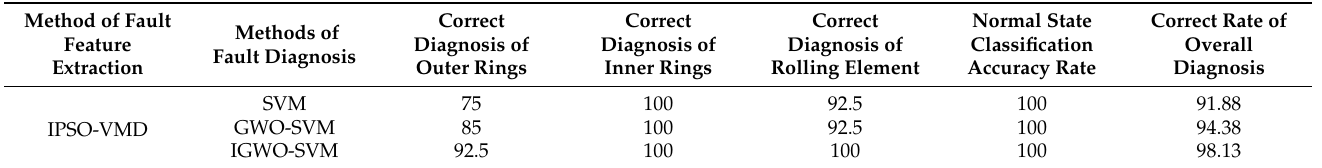
Table 2. Fault diagnosis results with different algorithms.